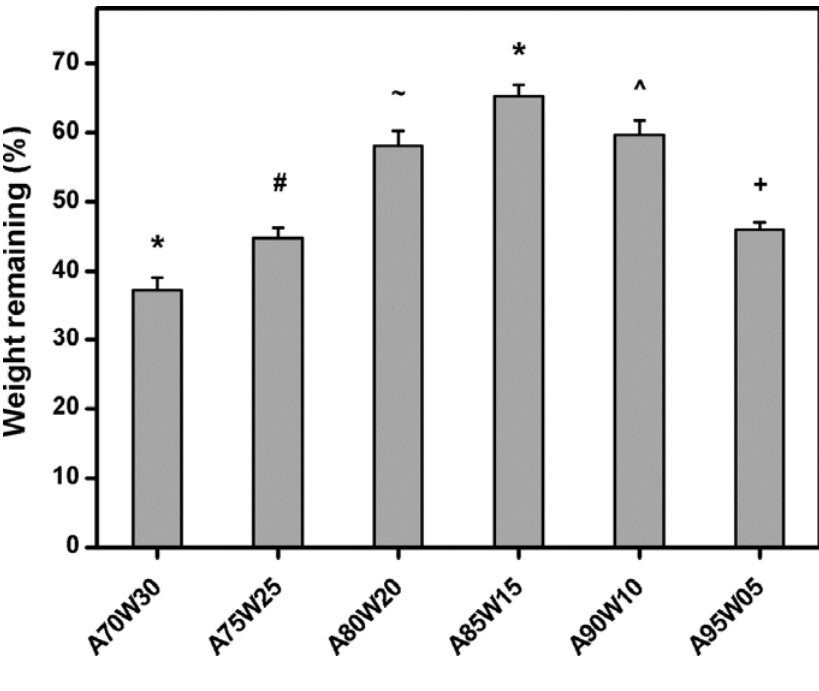
Figure 3. Weight remaining of various EDC cross-linked HA membranes after incubation at 37 °C for 36 h in BSS containing hyaluronidase. Values are mean ± SD ( n = 5). * P < 0.05 vs. all groups; # P < 0.05 vs. all groups, except A95W05; + P < 0.05 vs. all groups, except A75W25; ~ P < 0.05 vs. all groups, except A90W10; ^ P < 0.05 vs. all groups, except